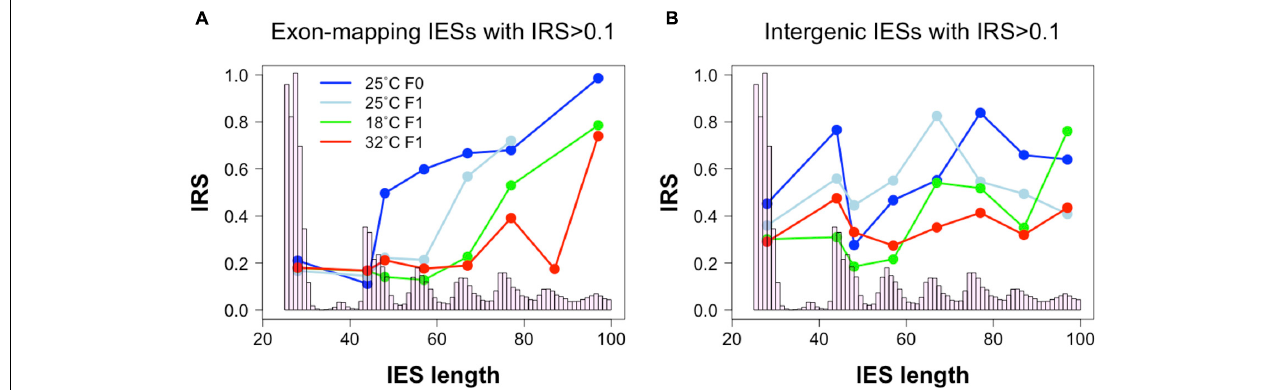
FIGURE 4 | Relationship between IES size and IES Retention Score (IRS). (A) The median IRS of small IESs, but not of large IESs, is comparable between F0 and F1 cells cultivated at 25 ◦ C (dark and light blue lines) and at the non-standard culture temperatures of 18 ◦ C (green line) and 32 ◦ C (red line). (B) In IESs that map to intergenic regions no clear IES size-related trend is discernible. Median IRS values were calculated using incompletely excised IESs that fall in the most frequent size classes (bp): 26–30, 44–45, 46–50, 54–60, 64–70, 74–80, 84–90, and 94–100. Only size classes with ≥ 3 incompletely excised IESs per condition were